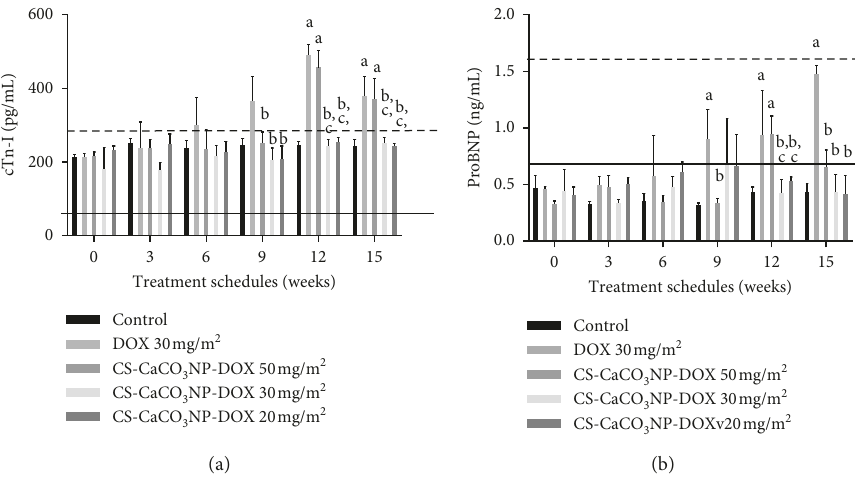
Figure 5: Cardiac injury biomarker. (a) Mean cardiac troponin I (cTn-I) concentration (pg/ml). (b) Mean N-terminal pro-brain natriuretic peptide (proBNP) concentration (ng/ml) of treatment groups from onset to 3 weeks after the 5th dose. Values are expressed as mean standard deviation. Different alphabets indicate statistical significance ( p 0 . 05) between groups at different cumulative doses with a, b, c, and d representing significant difference with control, DOX 30mg/m 2 , CS-CaCO 3 NP-DOX 50mg/m 2 , CS-CaCO 3 NP-DOX 30 mg/m 2 , and ± CS-CaCO 3 NP-DOX 20mg/m 2 , respectively. <